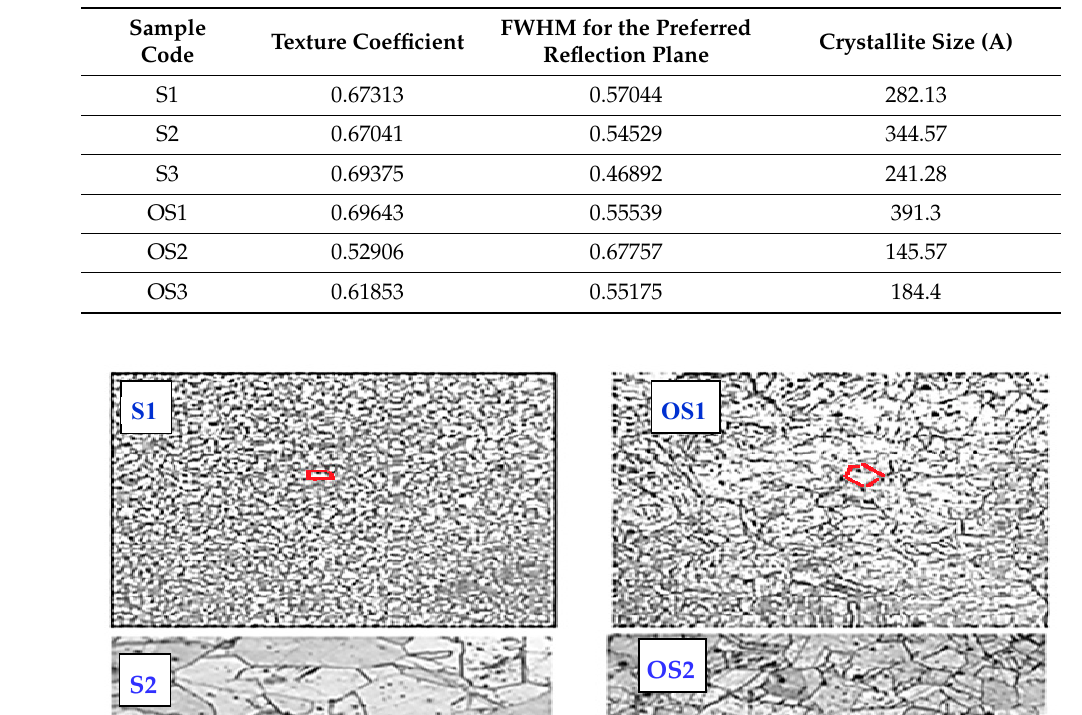
Table 2. Texture coefficient, FWHM and Crystallite size obtained by XRD analysis.